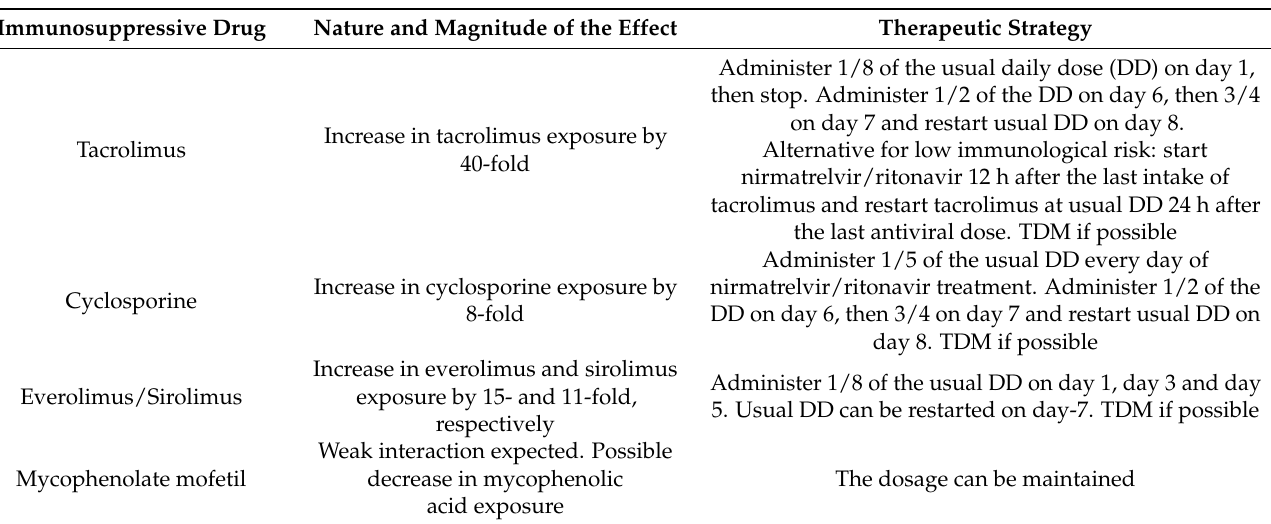
Table 8. Guidelines of the French Society of Pharmacology and Therapeutics